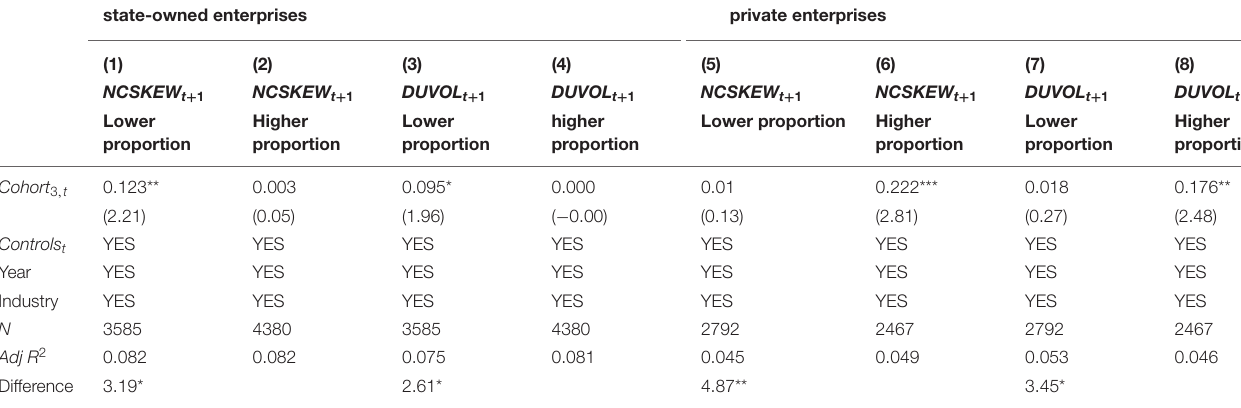
TABLE 16 | The moderating effect of managers’ power measured by the first shareholder’s shareholding